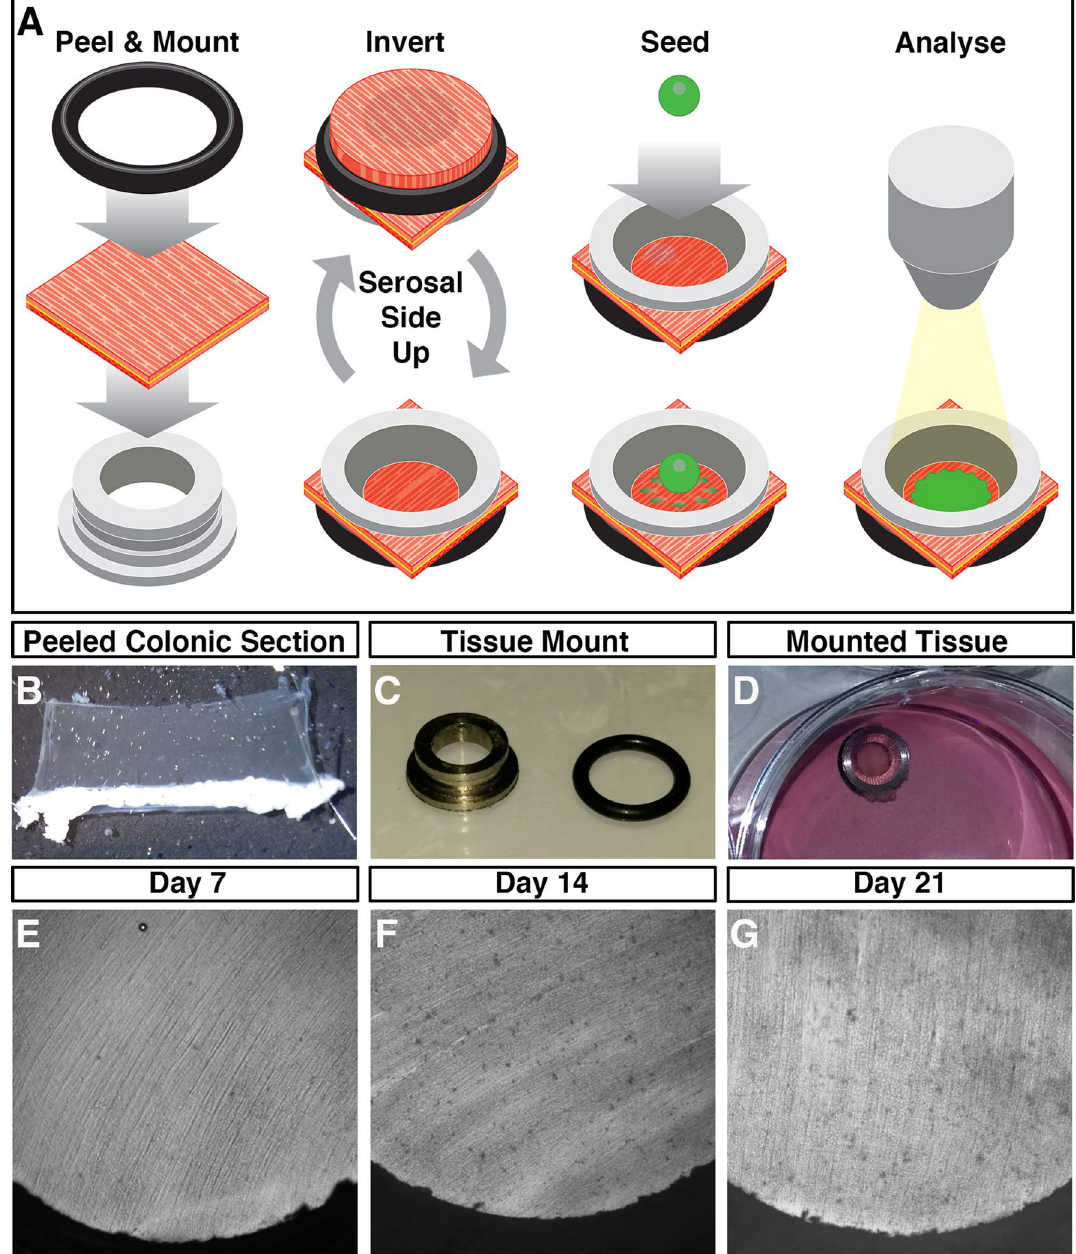
Figure 1. Ex vivo organotypic culture of colonic tissue. ( A ) Schematic representation of ex vivo gut culture methodology and the strategy used to perform ENSC transplantation. Illustration created by UCL Medical Illustration. ( B ) Representative image of colonic tunica muscularis after fine dissection of the mucosal layer. ( C ) Representative image of tissue mounting apparatus. ( D ) Representative image of mounted colonic tissue segment in organotypic culture. ( E – G ) Representative images of cultured colonic tissues at Day 7 ( E ), Day 14 ( F ), and Day 21 ( G ) demonstrating the absence of contamination, and lack of gross tissue damage, within long- term organotypic